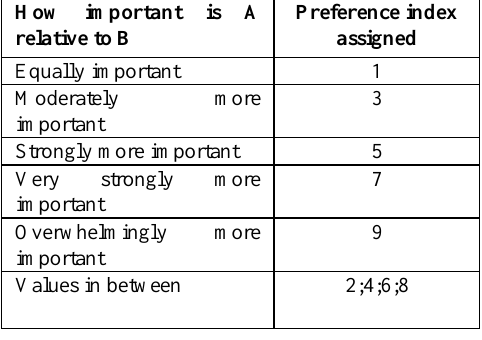
Table 3. AHP weighting scale (Saaty 1980)